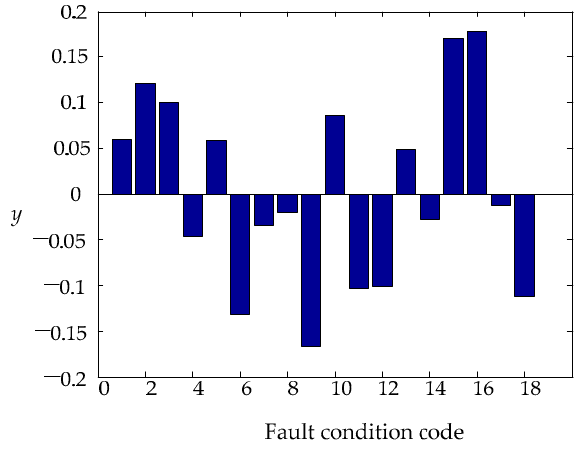
Figure 20. Eighteen kinds of fault condition fitting results.